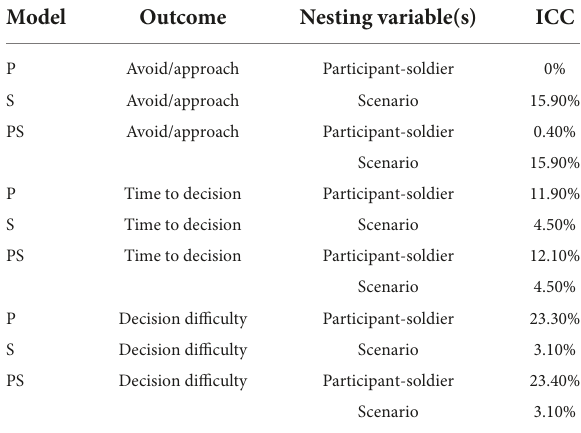
TABLE 1 Participant-soldier, and scenario nesting models.